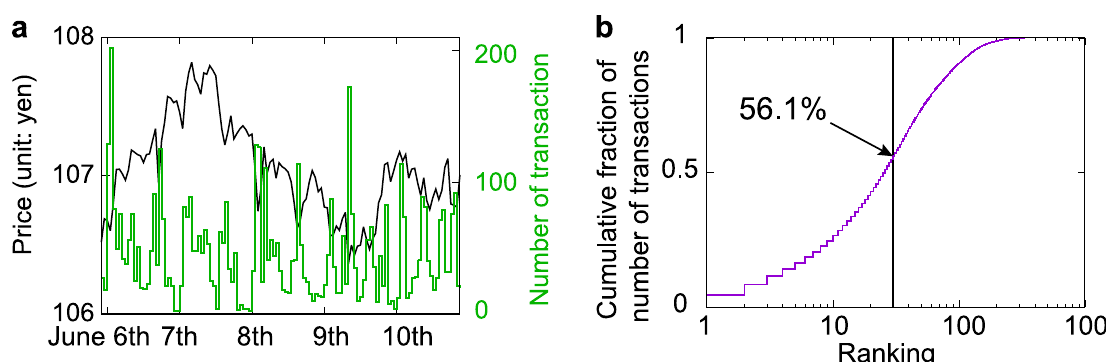
Fig 1. Basic market properties in the week commencing 5 June 2016. (a) Hourly market mid-prices of the USD/JPY pair (black) and number of transactions (green). See S1 Appendix for the distribution of transaction volumes. (b) Fraction of the total number of transactions over the whole week as a function of bank ranking. We order banks by decreasing numbers of transactions. The vertical axis shows the fraction of the total number of transactions by the subset of banks that have ranks equal to or less than the rank given in the horizontal axis. The black line divides the top 30 banks from the other banks, and it can be seen that the transactions of the top 30 banks account for about 56% of total number of transactions. We cumulate positions of traders to whom the same bank ID is attached, and define the total net trader positions as the bank